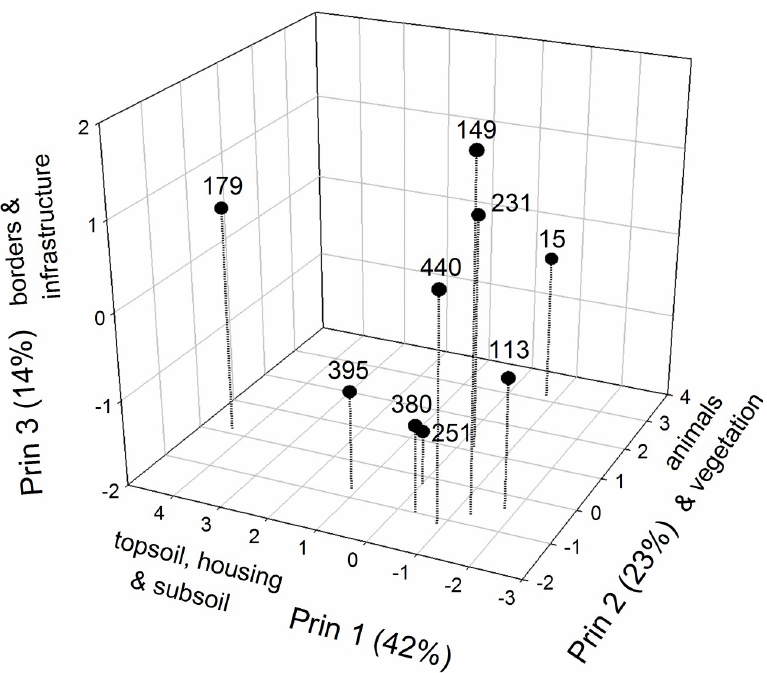
Fig 1. Visual representation of the separation of Dutch commons according to the number of regulatory activities pertaining to different types of shared resources. The first three principal components accounted for 79% of the total variance. According to eigenvectors (S2 Table) large positive values on Prin 1 reflect high importance of topsoil, housing, subsoil and unspecified resources; large positive values on Prin 2 reflect high importance of animals and vegetation resources; and large values on Prin 3 reflect high importance on borders and infrastructure. Key to Common IDs (15 = Mark Geesteren, Mander en Vasse, 113 = Mark Berkum, 149 = Mark het Gooi, 179 = Mark Exel, 231 = Dunsborger Hattemer mark, 251 = Mark Coevorden, 380 = Mark Bestmen, 395 = Mark Rozengaarde, 440 = Mark Raalterwold.